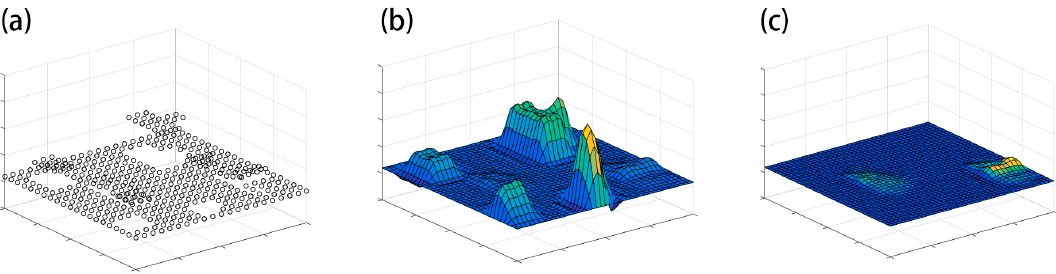
Figure 5. The schematic diagram of statistical analysis-based DTM generation method. ( a ) Raw Lidar points; ( b ) Global (local) high points filtered through statistical analysis; ( c ) DTM generated without filtered points.